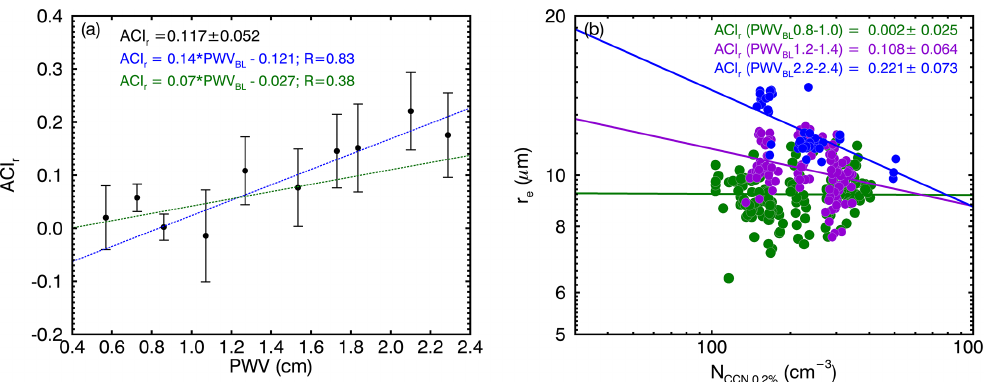
Figure 3. (a) Relationship of ACI r (dots) to binned PWV BL . Whiskers denote 1 standard deviation for each bin. Linear regressions are performed in a relatively low PWV BL regime ( < 1.4cm, green) and high-PWV BL regime ( > 1.4cm). (b) Illustration of ACI r derived from r e against N CCN , 0 . 2% in the following three PWV BL bins: 0.8–1.0cm (green), 1.2–1.4cm (purple), and 2.2–2.4cm (blue). ACI r represents the relative change in r e with respect to the relative change in N CCN , 0 . 2% , where positive ACI r denotes the decrease in r e with increased N CCN , 0 . 2% under binned